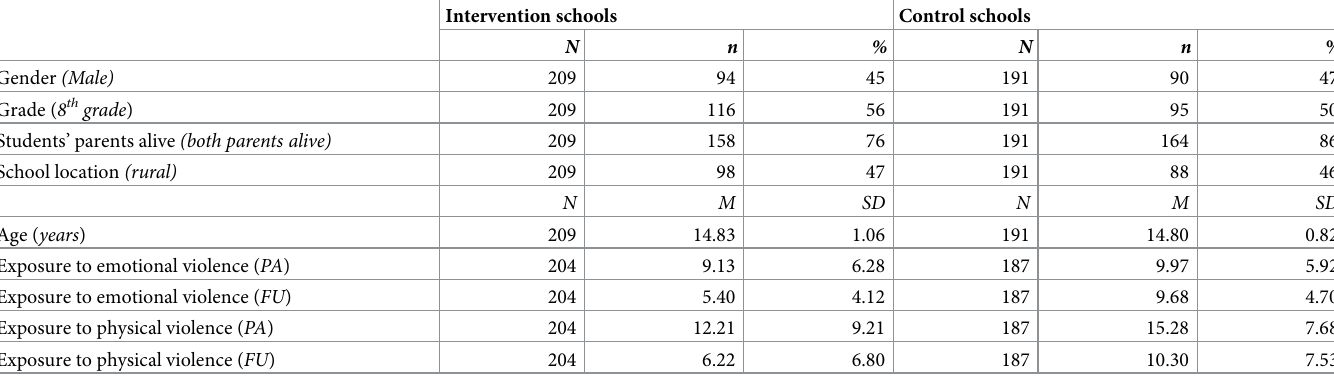
Table 2. Descriptive statistics of student sample in intervention and control schools at pre- and follow-up assessment.